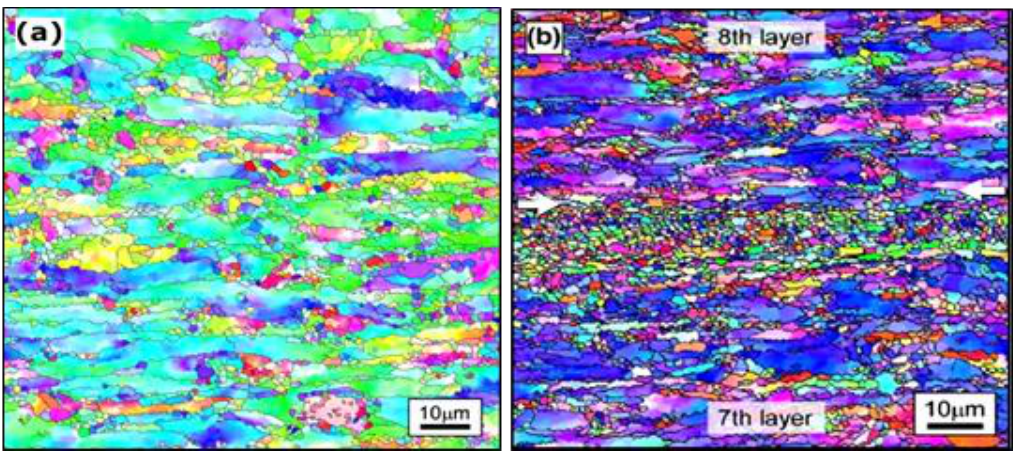
Figure 9. ( a ) The Inverse Pole Figure (IPF) map of as-received original AA 3003 alloy foil in which the grains are elongated along the rolling plane, and fine equiaxed grains are observed between the elongated grains, ( b ) The IPF of the VHP-UAM sample in which the interface region is represented by the white colored arrows. Many grains in the both top and bottom bulk regions are elongated along the rolling plane of the original tape, and fine grains are seen between these elongated grains, while all grains in the interface region are fine and equiaxial [132].